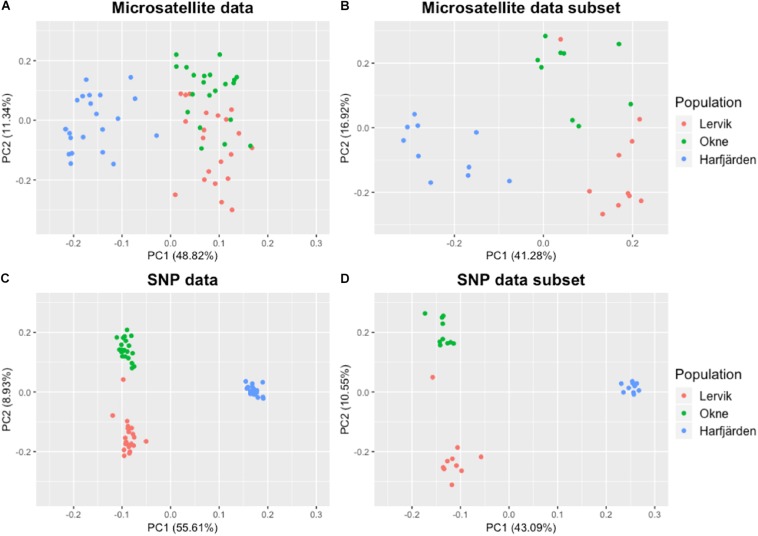
PCA plots based on pairwise similarity (proportion of alleles shared) among individuals. Plots are based on (A) full microsatellite dataset (10 loci, N = 64), (B) subset microsatellite dataset (10 loci, N = 30), (C) full RADseq SNP dataset (1580 biallelic SNPs, N = 64), and (D) subset RADseq SNP dataset (1670 biallelic SNPs, N = 30).